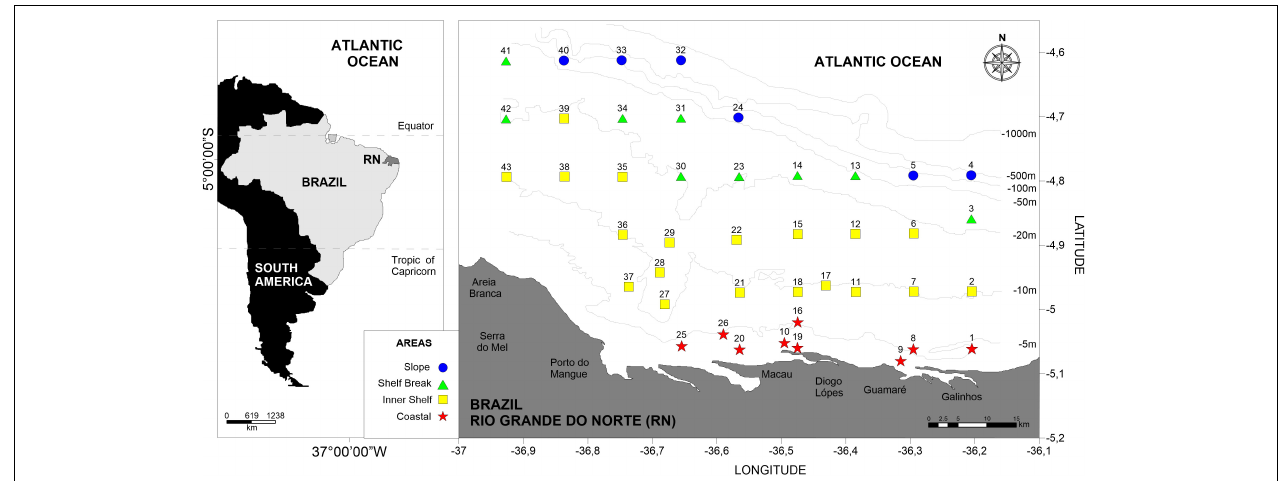
FIGURE 1 | Study area and stations located at the coastal and oceanic areas off Rio Grande do Norte, Southwestern